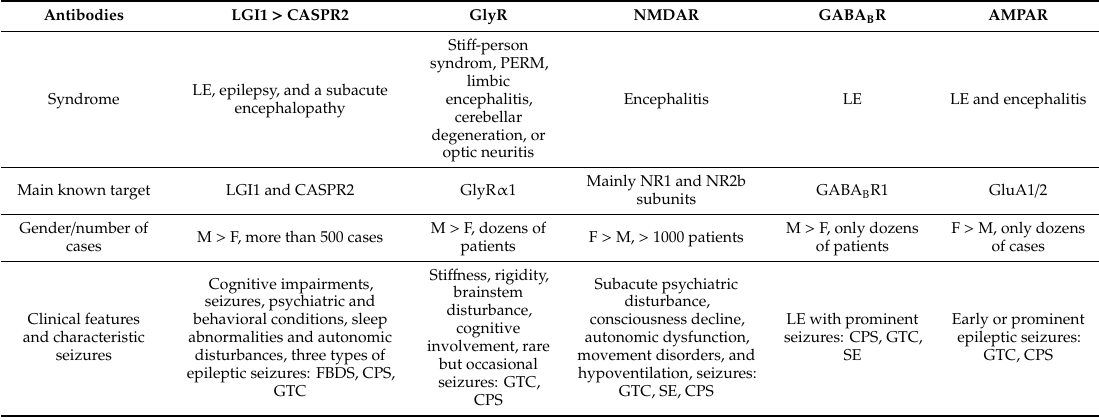
Table 1. Specific autoantibodies against surface neuronal proteins associated with seizure